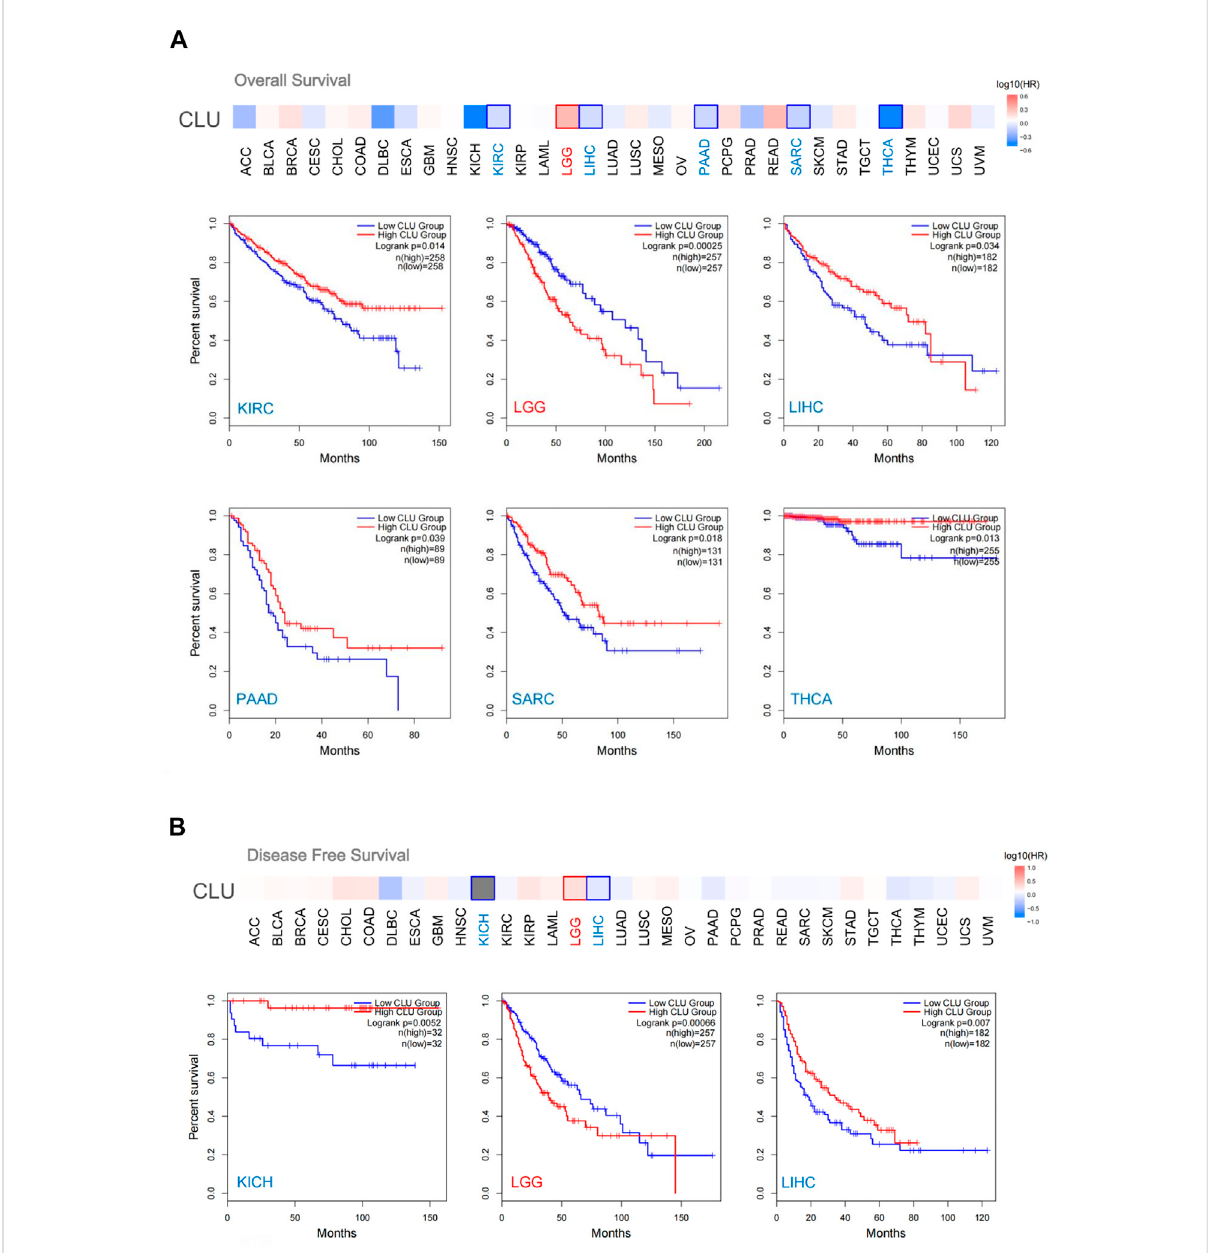
FIGURE 3 GEPIA2 was utilized to investigate the relation between CLU gene expression and OS prognosis in all TCGA cancers. (A) OS analysis; (B) DFS analysis, survival map and Kaplan-Meier plots provided encouraging fi ndings with substantial